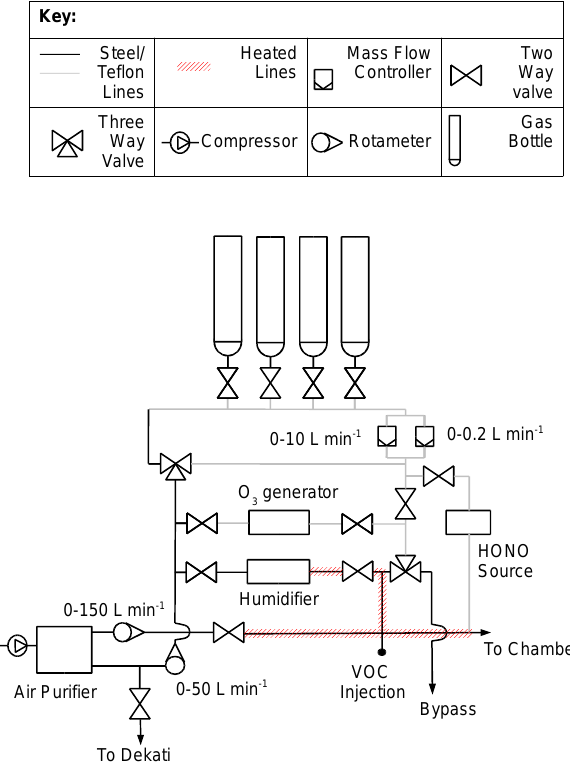
Fig. 2. Schematic (not to scale) of the primary component injection system of the mobile chamber. Pure air may be injected directly into the chamber through the main injection line, an insulated 12mm (outer diameter) stainless steel tube which can be heated up to a maximum of 150 ◦ C (red hatching, “To Chamber”). All or part of the pure air stream may be diverted through different sections of the primary injection system using a series of two- and three-way